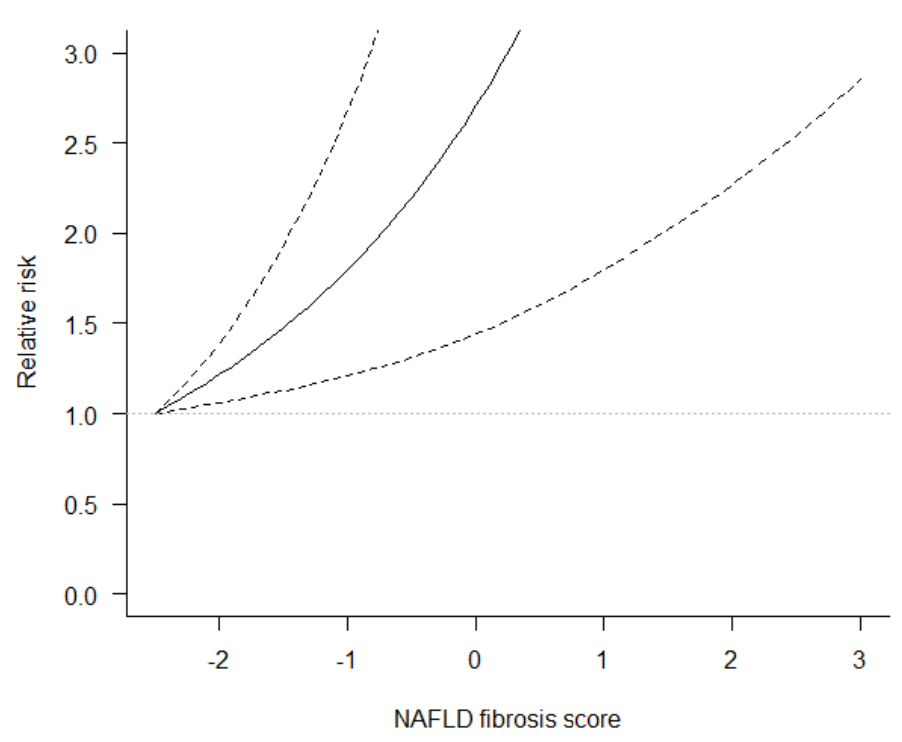
Figure 3. Dose-response association between NAFLD fibrosis score and mortality risk in NAFLD patients. Solid lines represent risk ratio, dashed lines represent 95% confidence intervals.